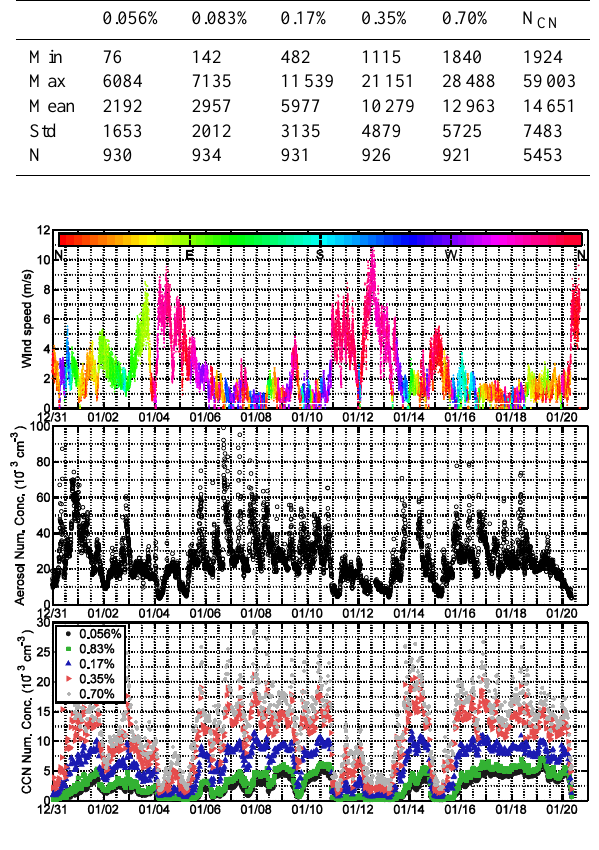
3 Fig. 4. Time series of wind (a) , Aerosol (b) and CCN (c) number